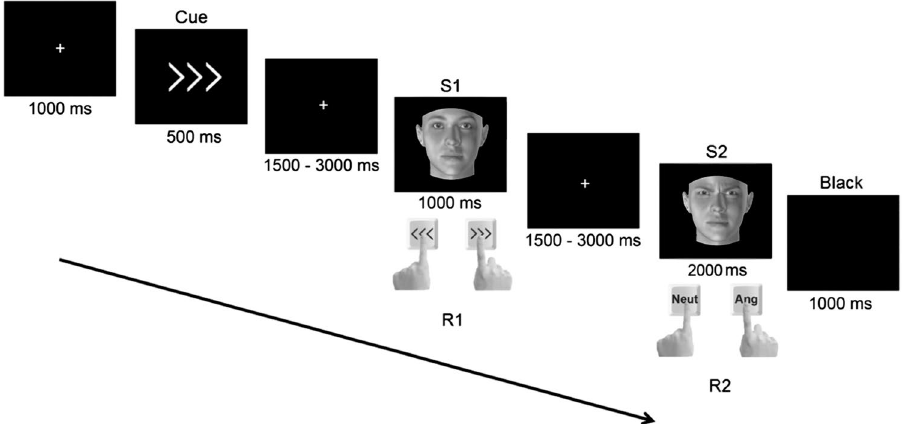
Figure 6. Overview of the displays and timing of events in the experiment. A cue (a left or right-pointing arrow) is presented announcing the response (R1) to be given to a first angry or neutral face (S1). Then a second angry or neutral face (S2) appears and participants have to answer (R2) given the emotion expressed by